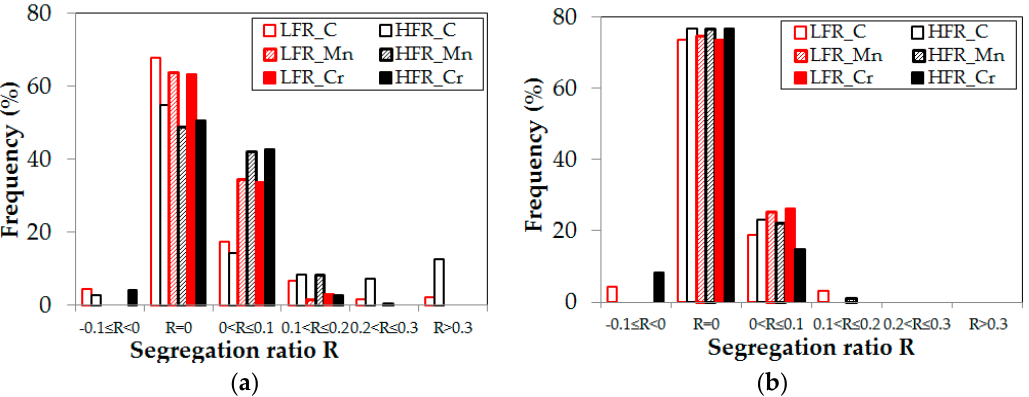
Figure 3. Frequency distribution of segregation ratios: ( a ) In the hot-top; ( b ) In the upper section of ingot body.